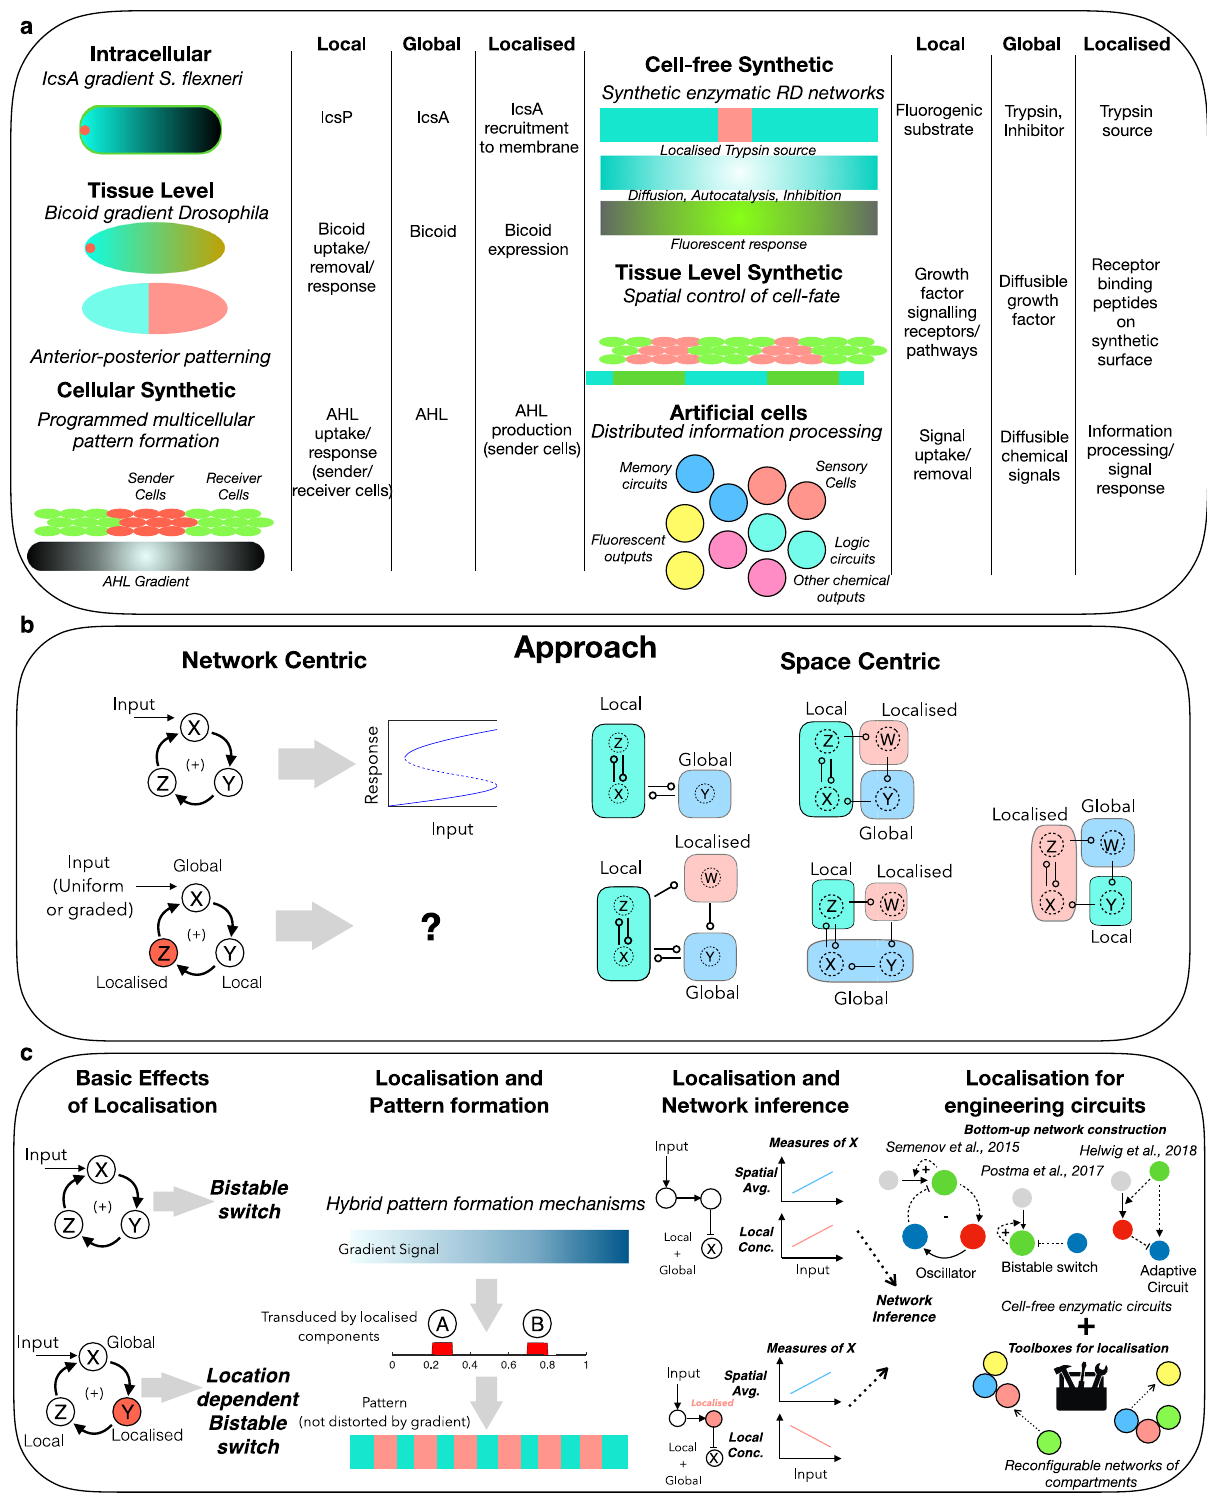
Fig. 1 Schematic summary of the focus of the paper, the ingredients, approaches and types of insights. a Schematic summarising the central role of the interplay between local (non-diffusible/slow diffusing), global (diffusible/fast diffusing), and localised components, in multiple contexts of biochemical information processing in natural and engineered biology and at their junction (related references: Robbins et al. 1 , Durrieu et al. 49 , Basu et al. 50 , Semenov et al. 9 , Li et al. 14 , Joesaar et al. 13 ). b Schematic illustrating the two complementary approaches used in our study, bringing together networks and spatial classes. See ‘ Methods ’ for details. c Schematic summarising the types of insights emerging from the study, elucidating the role of localised components in spatial and temporal information processing by biochemical networks. combining basic effects, the impact on pattern formation, the hidden role in network inference and the potential for engineering synthetic circuits (the results arising from the study are summarised in Fig. 10).